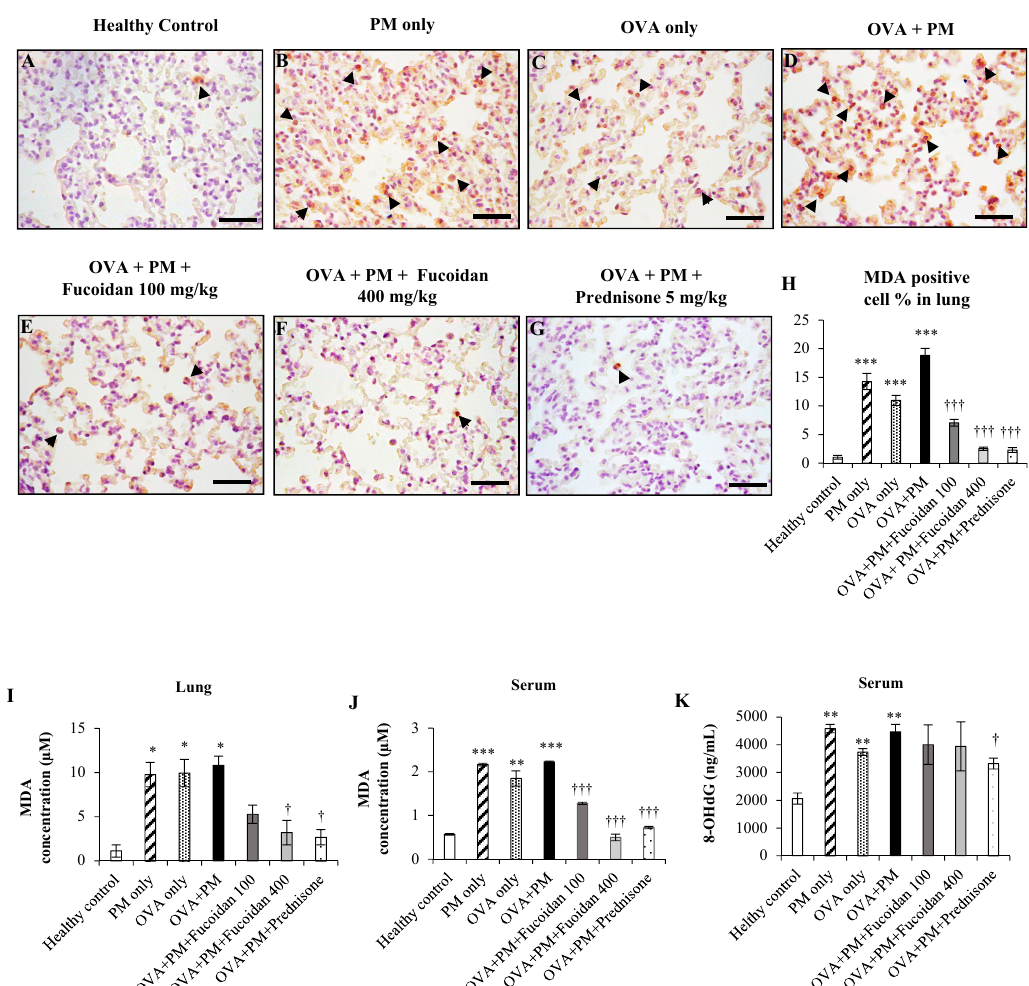
Figure 1. The e ff ect of fucoidans on the levels of MDA and 8-OHdG in the lungs and serum. The lung ( A – G ) MDA positive cells, ( H ) percentages of MDA positive cells and ( I ) the MDA level are presented. Serum ( J ) MDA and ( K ) 8-OHdG levels are presented. Values are expressed as means ± SEM ( n = 3). * ( p < 0.05), ** ( p < 0.05), *** ( p < 0.05) represent significant increases compared with the healthy control, and † ( p < 0.05) ††† ( p < 0.0005) represent significant decreases compared with the OVA + PM